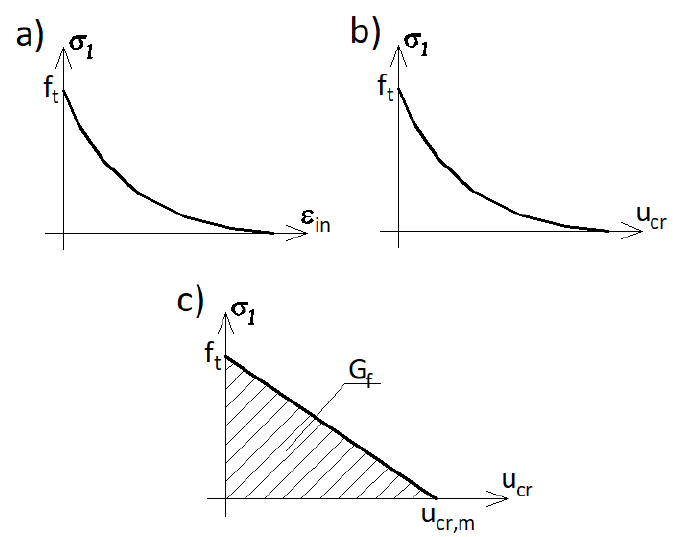
Figure 3. ( a – c ) CDP plastic flow potential surface in the meridian